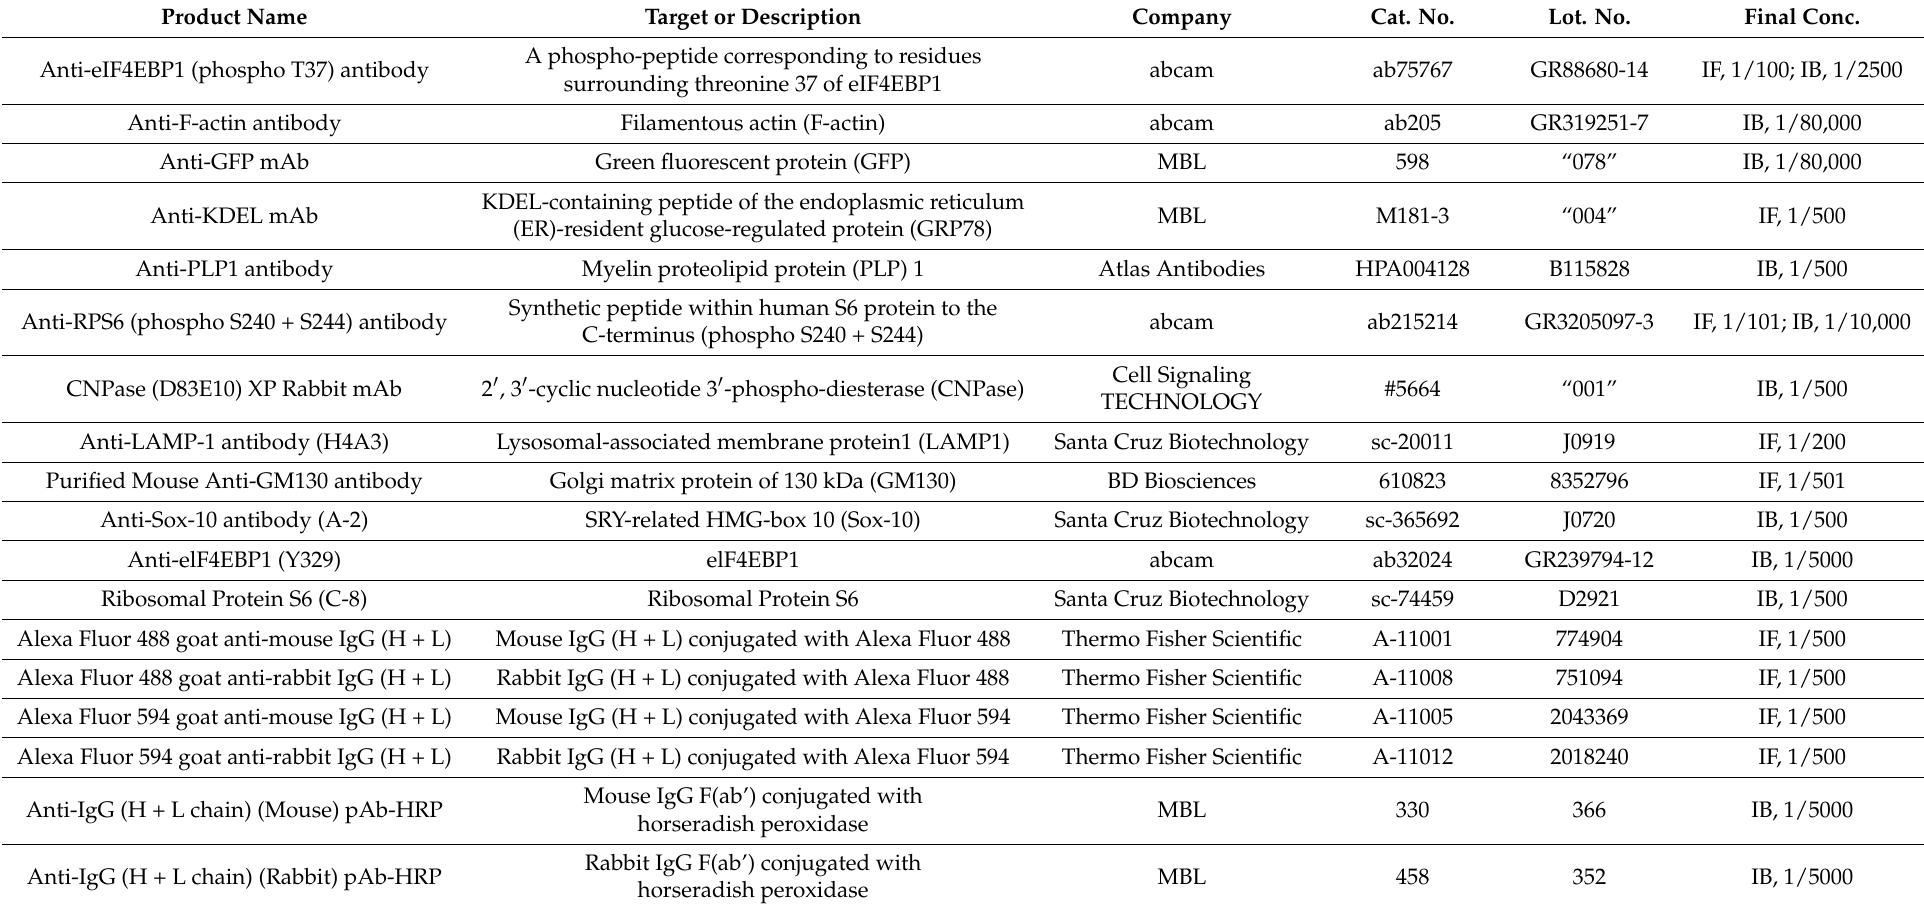
Table 1. Antibodies used in these